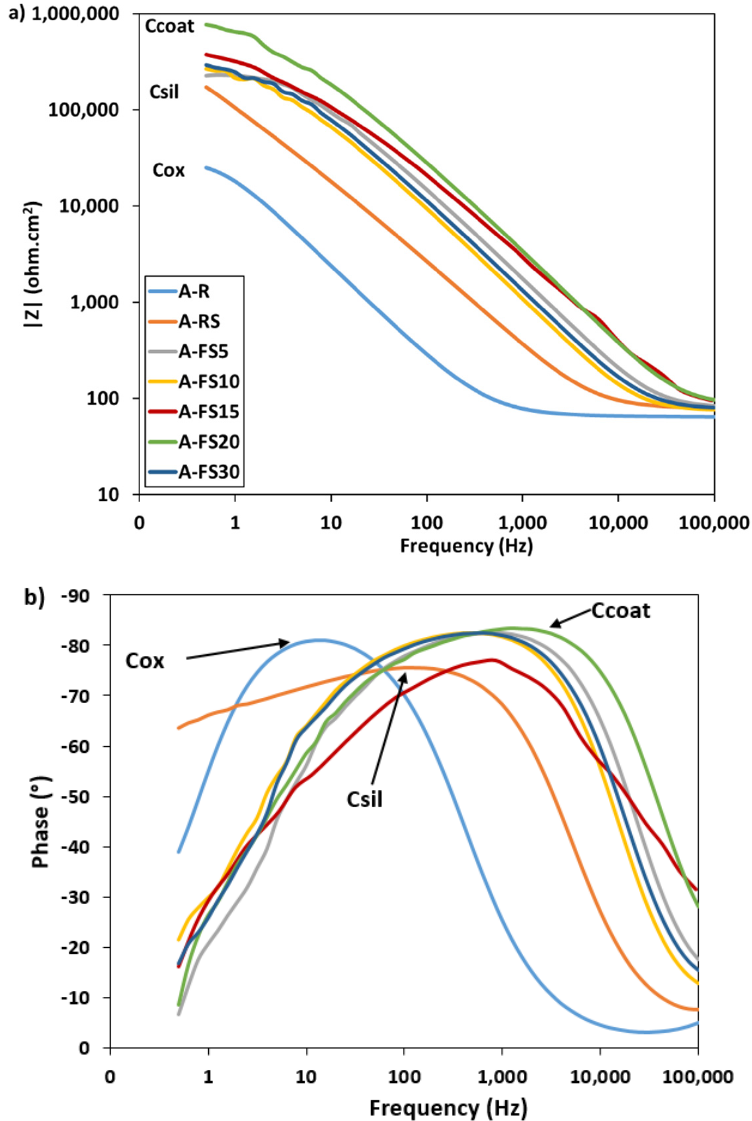
Figure 9. ( a ) Bode modulus and ( b ) phase plots of the as-received aluminum alloy and the superhy- drophobic samples.